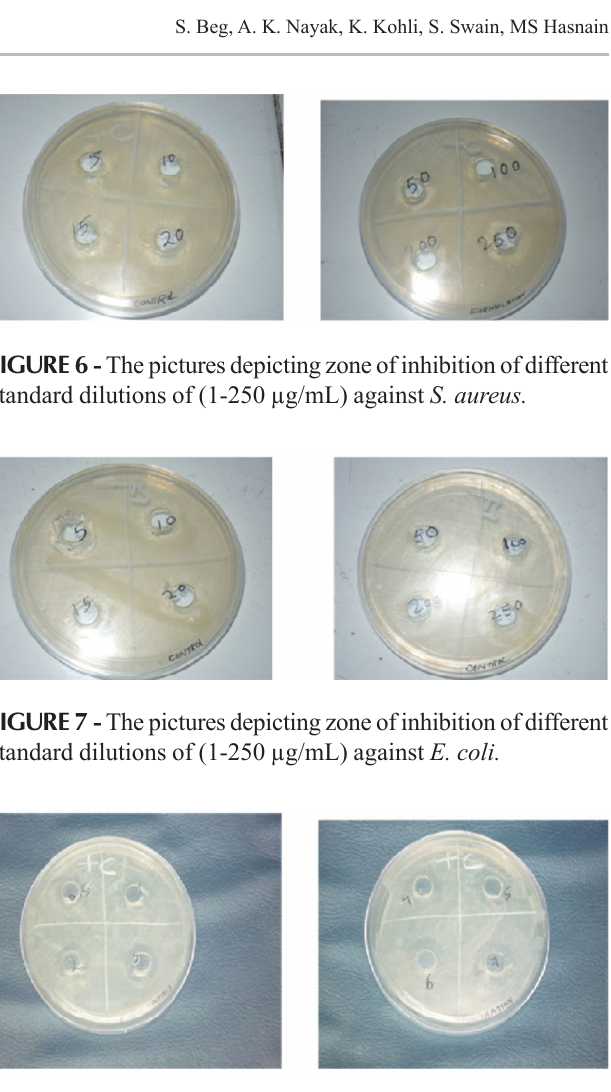
FIGURE 8 - The pictures depicting zone of inhibition of samples obtained from in vitro drug release study of time-dependent release bilayer tablet formulation (F2) of AMT in S. aureus.